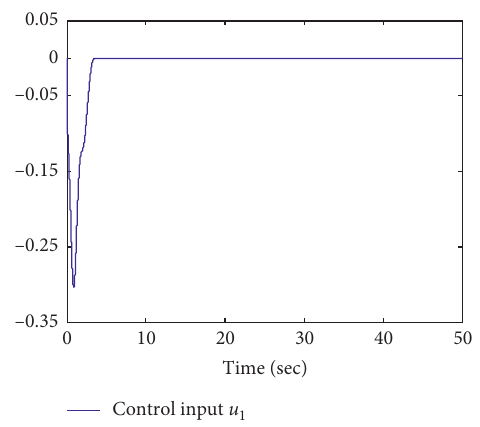
for the fuzzy 3